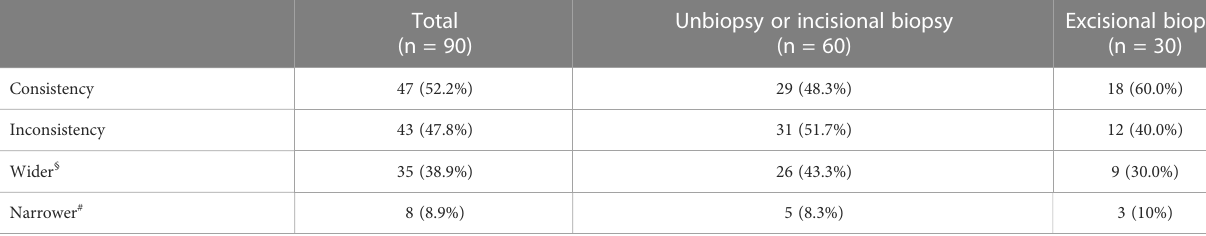
TABLE 3 Consistency of clinical and dermoscopic detection margin.